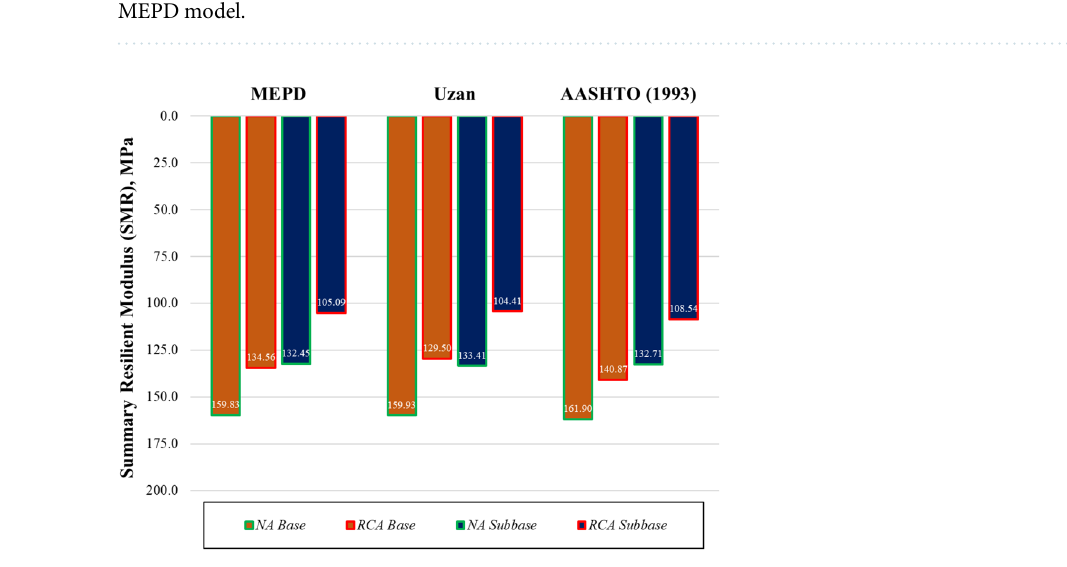
Figure 8. Calculated SMR values from different regression